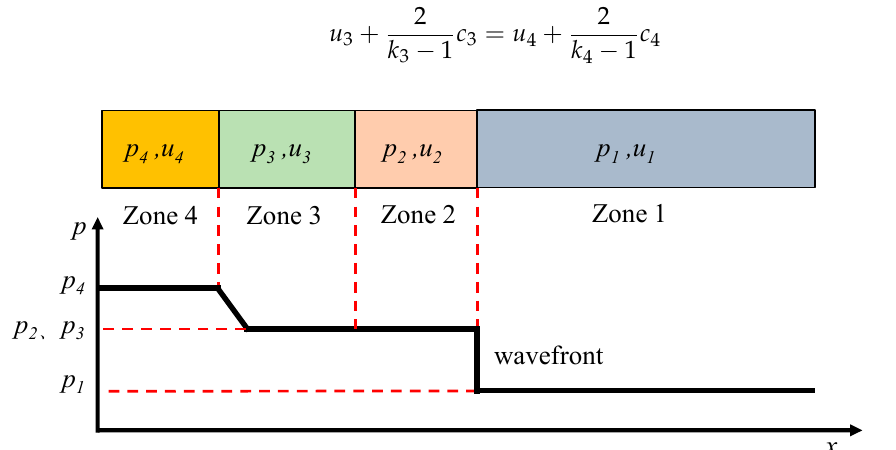
Figure 9. Pressure distribution in shock tube.